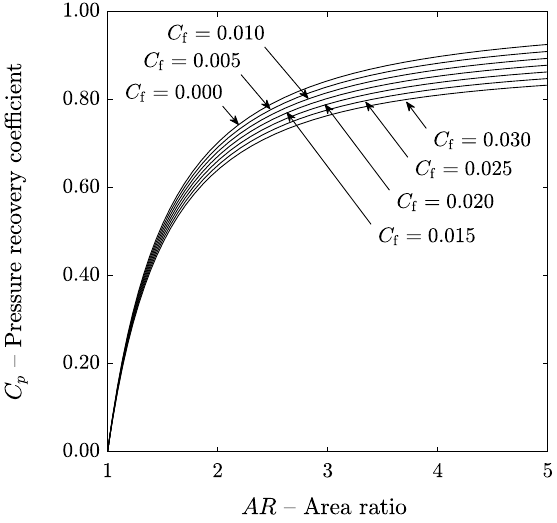
Figure 8. Influence of skin friction